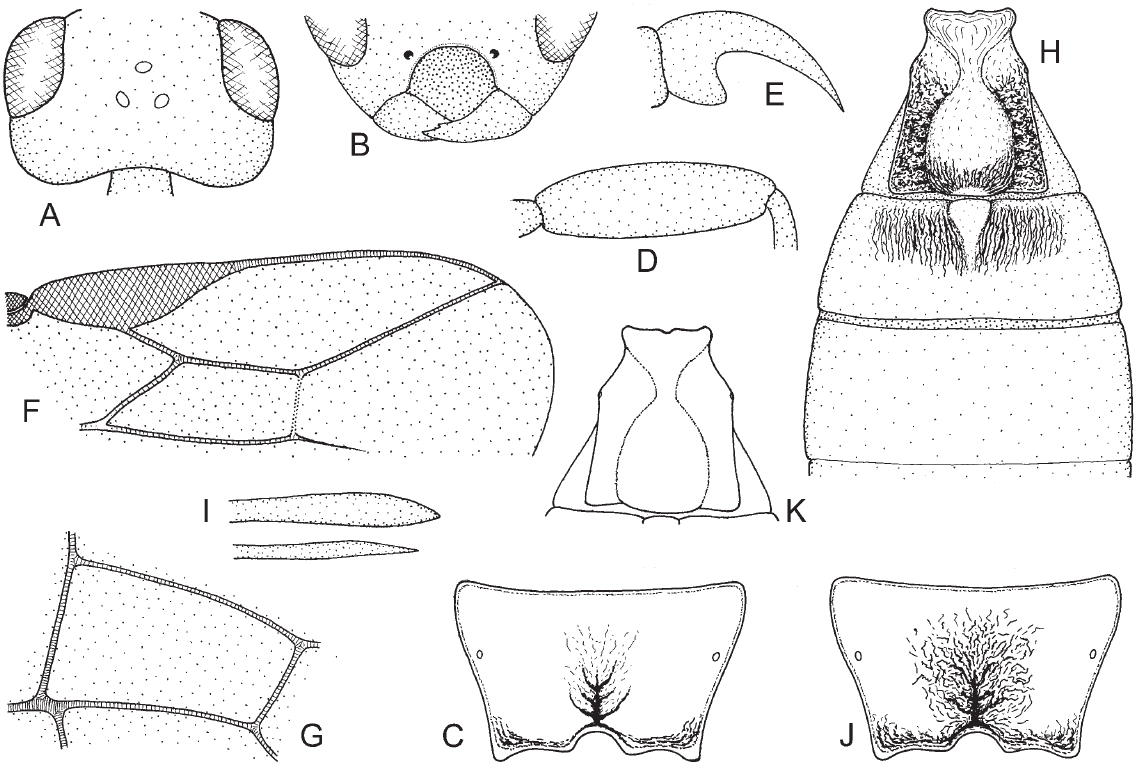
Fig. 16. Bracon ( Lucobracon ) larvicida Wesmael, 1838 (A-I: ♀ lectotype, J: ♀, K: ♀ / ♂). A . Head in dorsal view. B . Head in frontal view. C . Propodeum. D . Hind femur. E . Claw. F . Distal part of right forewing. G . First discal cell of right forewing. H . Tergites 1-3. I . Hind end of ovipositor apparatus. J . propodeum. K . First